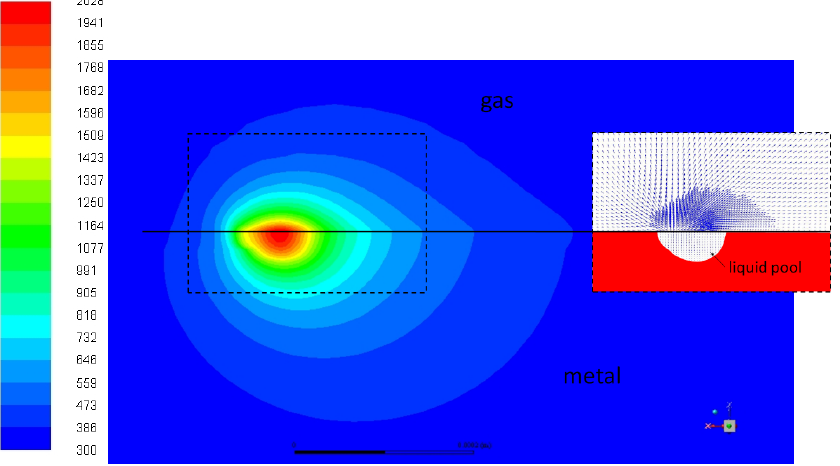
Figure 3. Thermal field and detail of fluid-dynamics around the melt pool, on the longitudinal symmetry plane (case of pure copper printed at 800 W and 1000 mm/s).